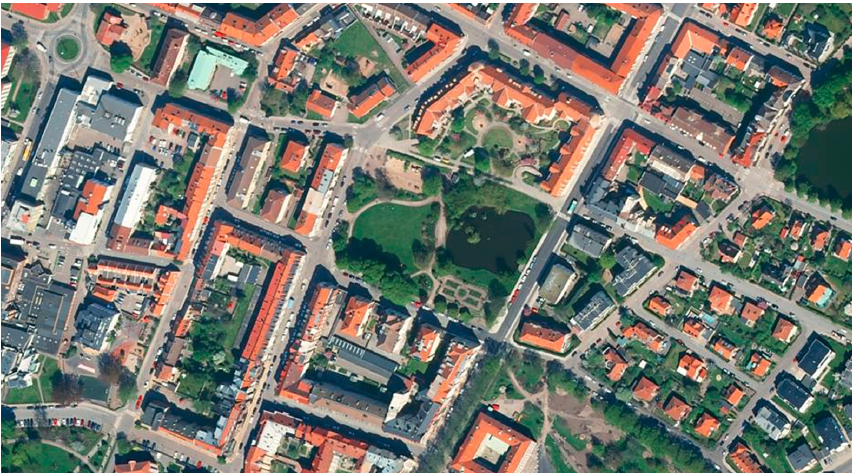
Figure 1. Wrangelska Parken and its surroundings. Background: GSD Orthophoto, 1 m colour © Lantmäteriet.